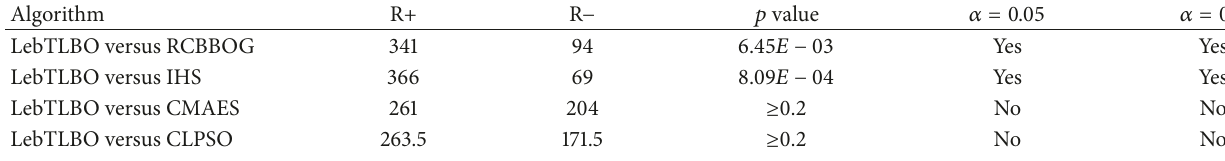
Table 6: Multiple-problem Wilcoxon signed-rank between LebTLBO and other MS algorithms.